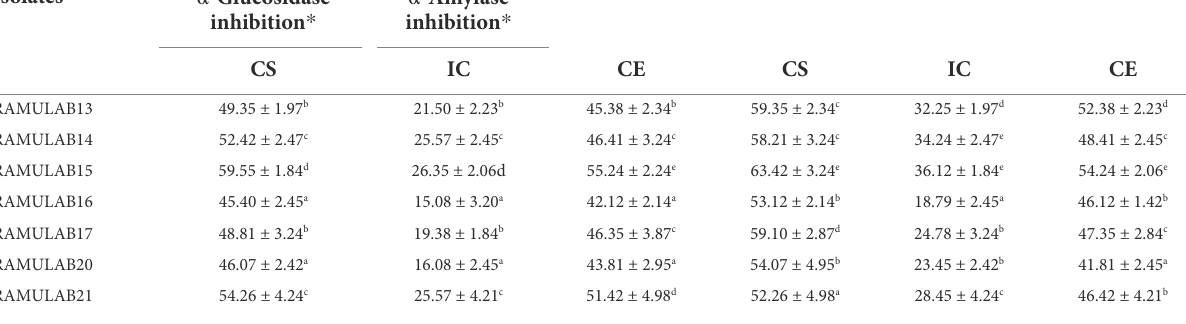
TABLE 7 α -Glucosidase and α -Amylase inhibitory activity of the isolates.